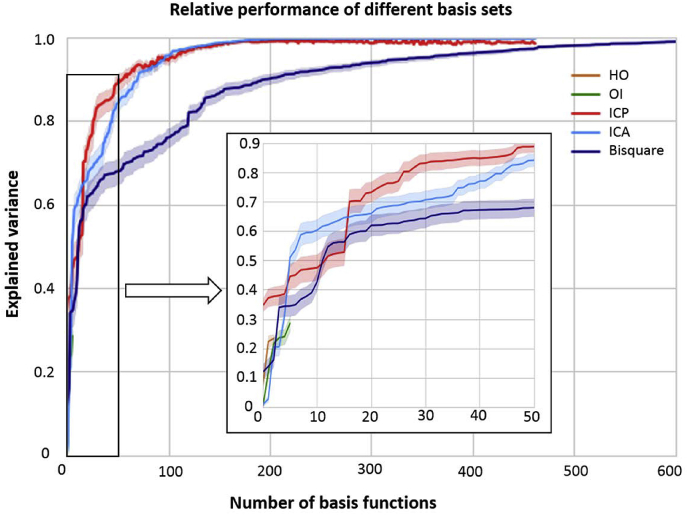
Explained variance (mean ± standard deviation across 100 subjects) as a function of the number of basis functions included in the model. Inset shows a zoom on the performance of all methods at low model orders.